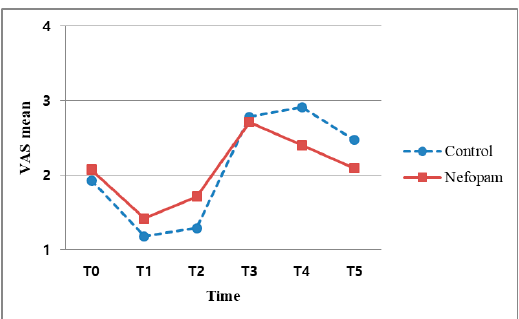
Figure 3. Association between VAS scores and time points without interscalene block.